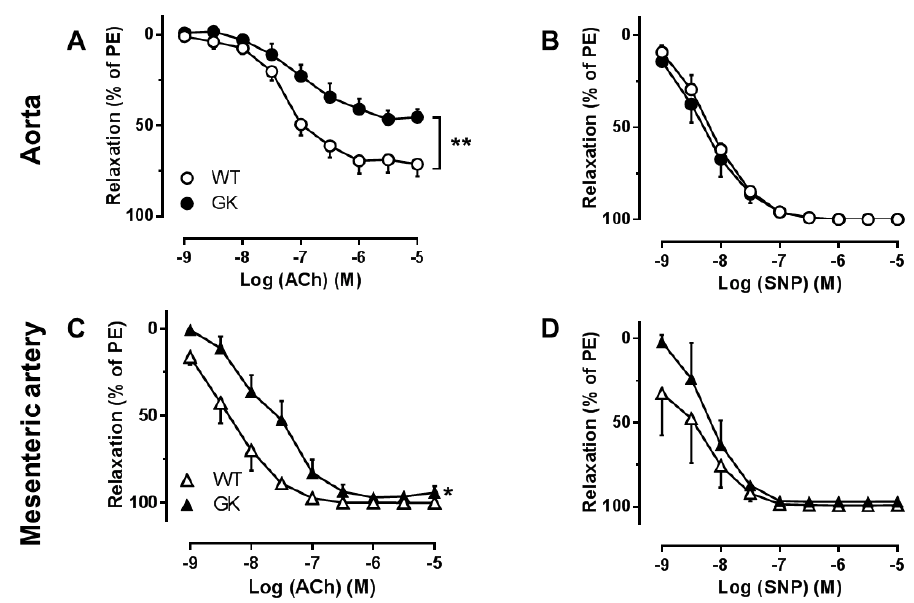
Figure 1. Concentration-response curve for acetylcholine (ACh) ( A , n = 10–18), representing endothelium-dependent relaxation (EDR) or sodium nitroprusside (SNP), representing endothelium-independent relaxation (EIDR) ( B , n = 3–4) in aortas isolated from Wistar (WT) and Goto-Kakizaki (GK) rats. EDR ( C , n = 8–10) as well as EIR ( D , n = 3) were also evaluated in mesenteric arteries from WT and GK rats. Data are presented as mean ± SEM as percentage relaxation of PE. * p < 0.05, ** p < 0.01, calculated with two-way ANOVA.